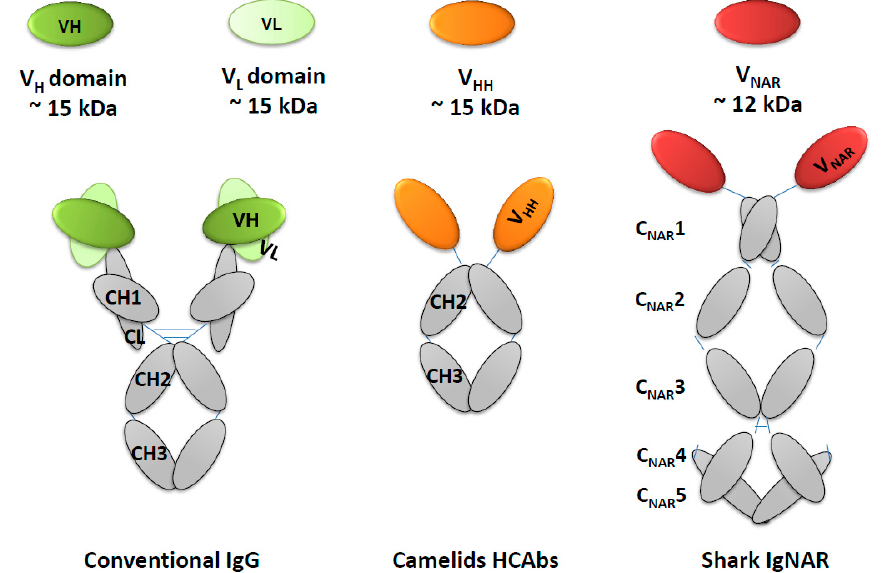
Figure 1. Schematic representation of the comparison conventional antibody IgG with natural single domain antibodies derived from camelids and sharks. Single V (colored ovals); C domains (grey colored). Each color in V domains VH, VL, or single heavy domain represents the specific source of animals.